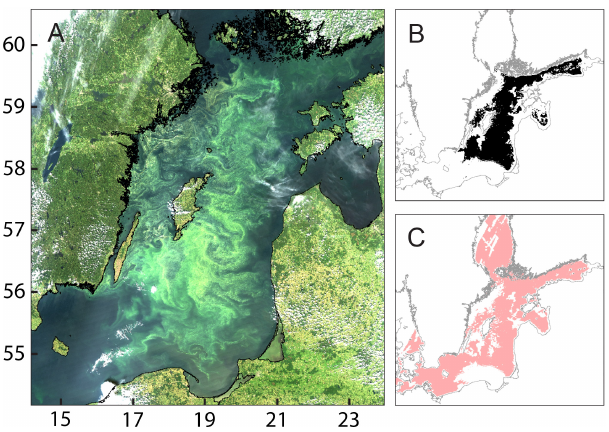
Figure 5. Example of cyanobacteria detection on MODIS-Aqua imagery of central Baltic Sea on 10 July 2005. (A) Quasi true- color image using bands 1 (red), 3 (blue), 4 (green). Small clouds (bright white) can be seen over both land and the sea. (B) Detected cyanobacteria accumulations (black). (C) Valid ocean areas (pink).